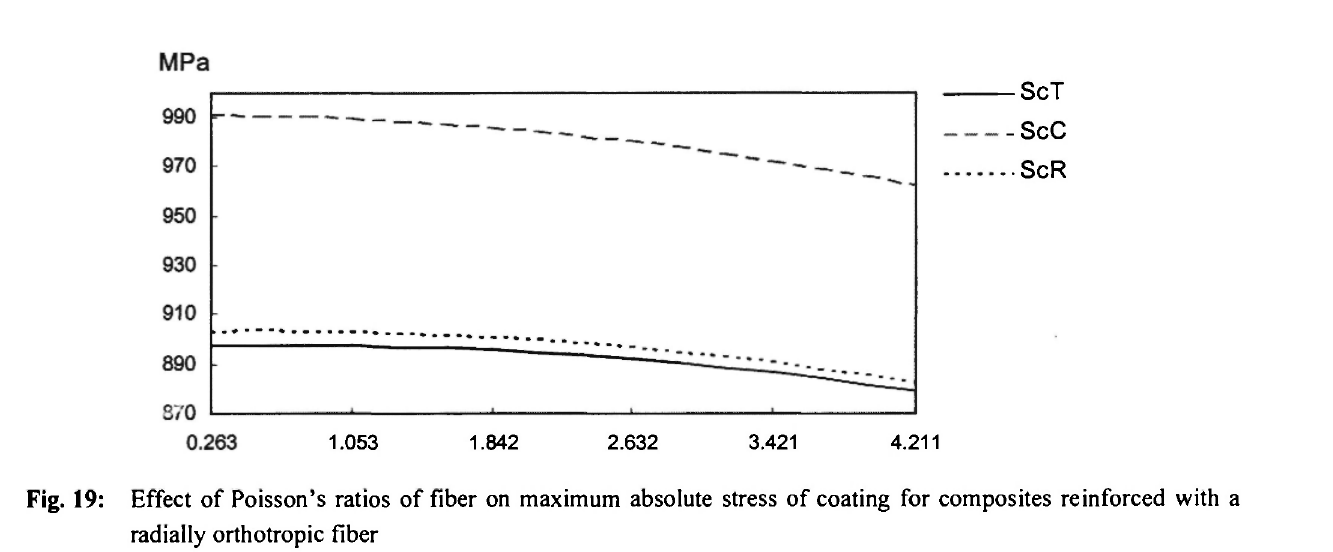
Effect of Poisson's ratios of fiber on maximum absolute stress of coating for composites reinforced with a radially orthotropic